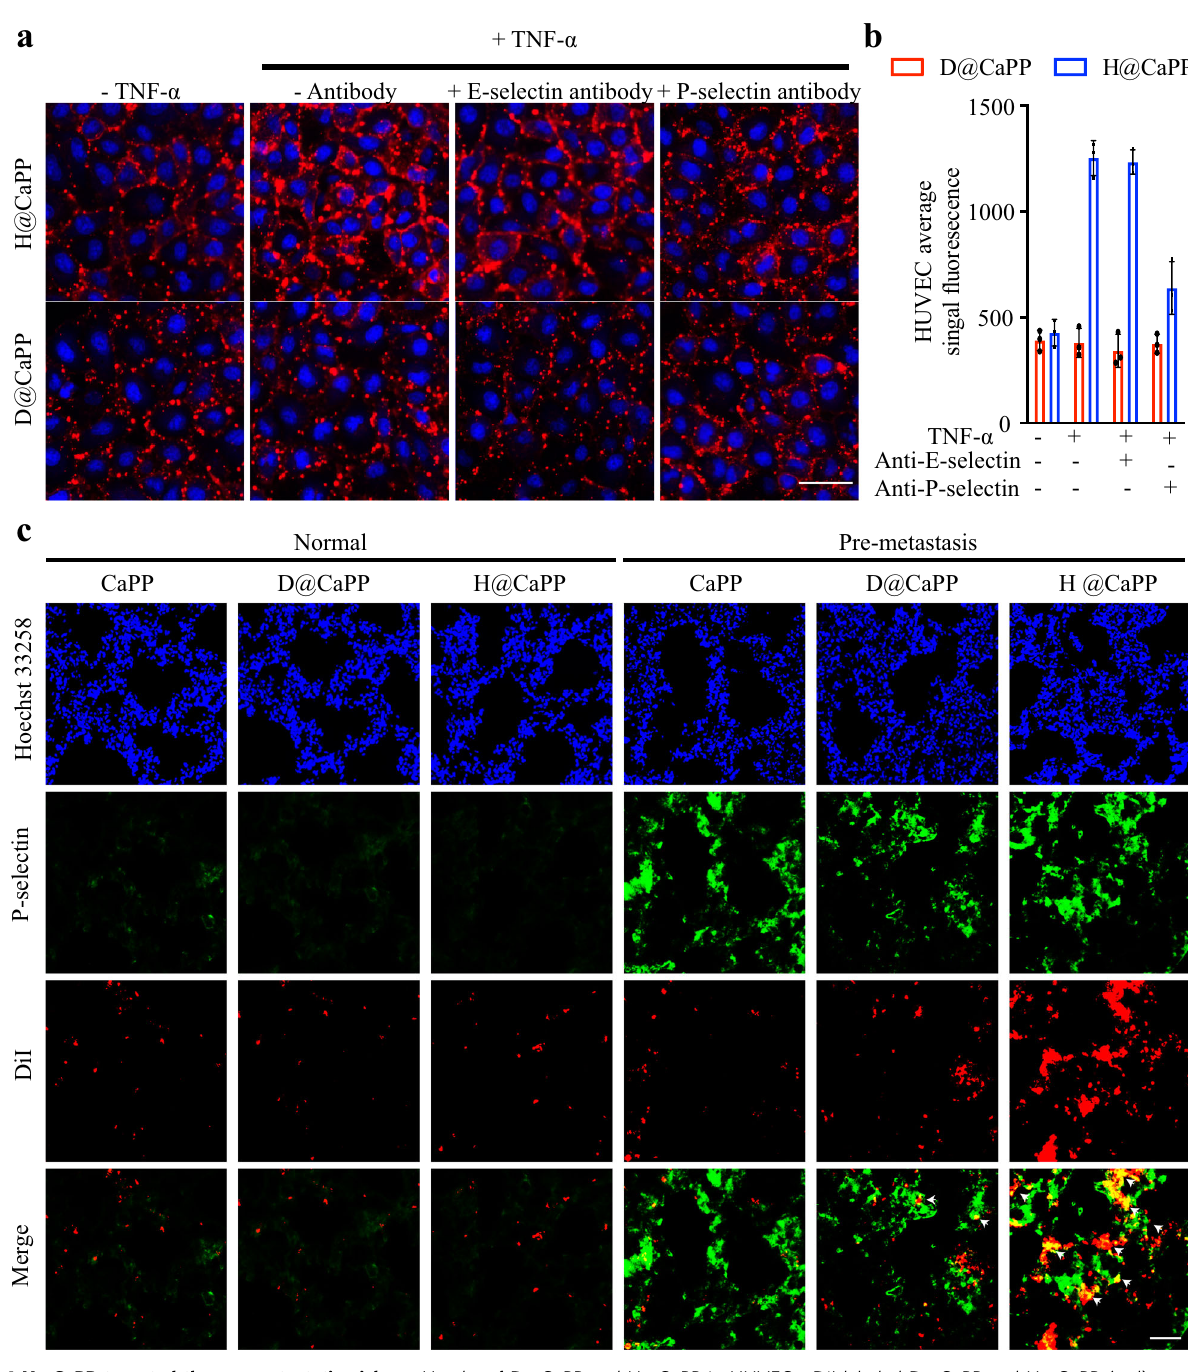
Fig. 4 H@CaPP targeted the pre-metastatic niche. a Uptake of D@CaPP and H@CaPP in HUVECs. DiI-labeled D@CaPP and H@CaPP (red) were incubated with a HUVECs pre-incubated with or without TNF- α (50 ng/mL, 4 h), respectively. In order to investigate the mechanism, an anti-P-selectin antibody was incubated with HUVECs for 2 h before adding nanotherapeutics. Afterward, HUVECs on a 6-wells plate was imaged after staining nuclei by Hoechst 33258 (blue) for eight minutes. Scale, bar, 20 μ m. b Quanti fi cation of HUVECs uptake of nanotherapeutics under various conditions (ANOVA, n.s. indicated no signi fi cant difference, mean ± SD, n = 3 images per group). c Expression of P-selectin in mice lungs examined by immuno fl uorescent staining. Normal mice and tumor-bearing mice were intravenously injected with DiI-labeled nanotherapeutics (1 mg/kg DiI), respectively. Blue: Hoechst 33258 stained nuclei; green: P-selectin pre-metastatic sites; red: DiI-labeled nanoparticles. Scale bar, 50 μ m. The experiments were repeated three times independently. Error bars represent